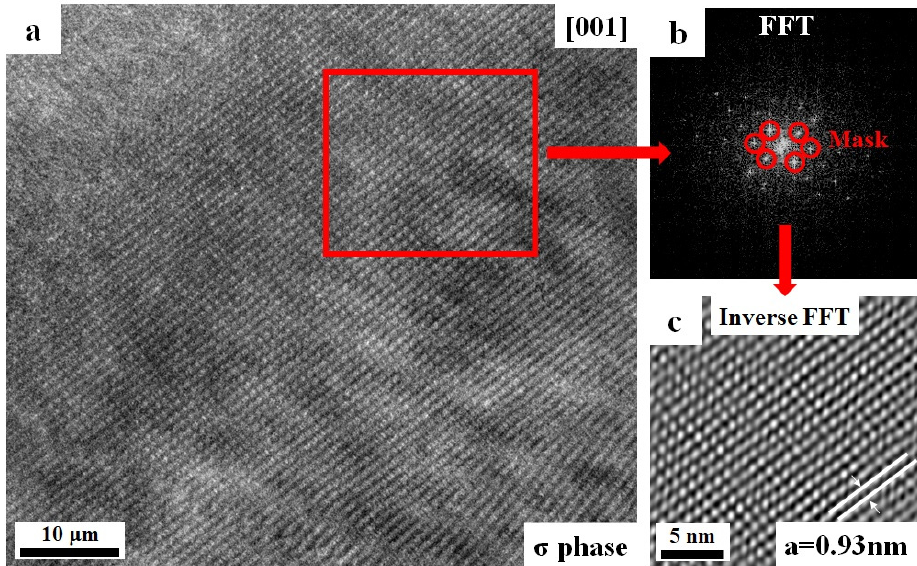
Figure 4. ( a ) The high–resolution TEM image of σ phase in (0 0 1) plane while the γ phase is in (1 1 1) plane; ( b ) fast Fourier transform patterns of the red rectangle in ( a ); ( c ) inverse fast Fourier transform image showing that lattice parameter a is 0.93 nm.